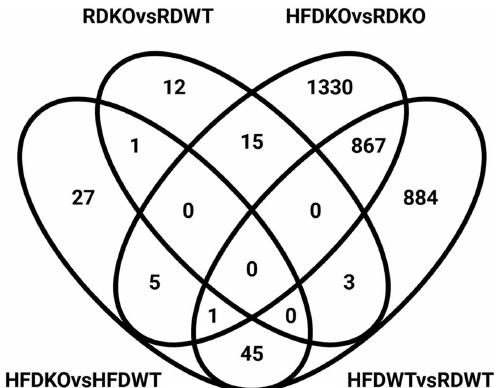
Figure 8. Venn diagram depicting the overlap among differentially expressed genes from each diet (chow or HFD) or genotype ( Lama4 fl/fl mice or Lama4 AKO ) comparison. RD = chow diet, HFD = high- fat diet, WT = Lama4 fl/fl and KO = Lama4 AKO .